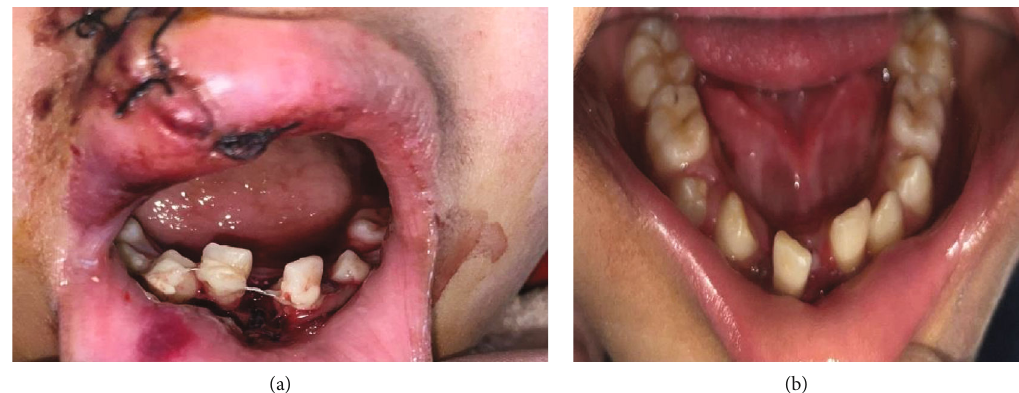
Figure 2: (a) Composite wire splint and (b) removal of splint after 4 weeks.